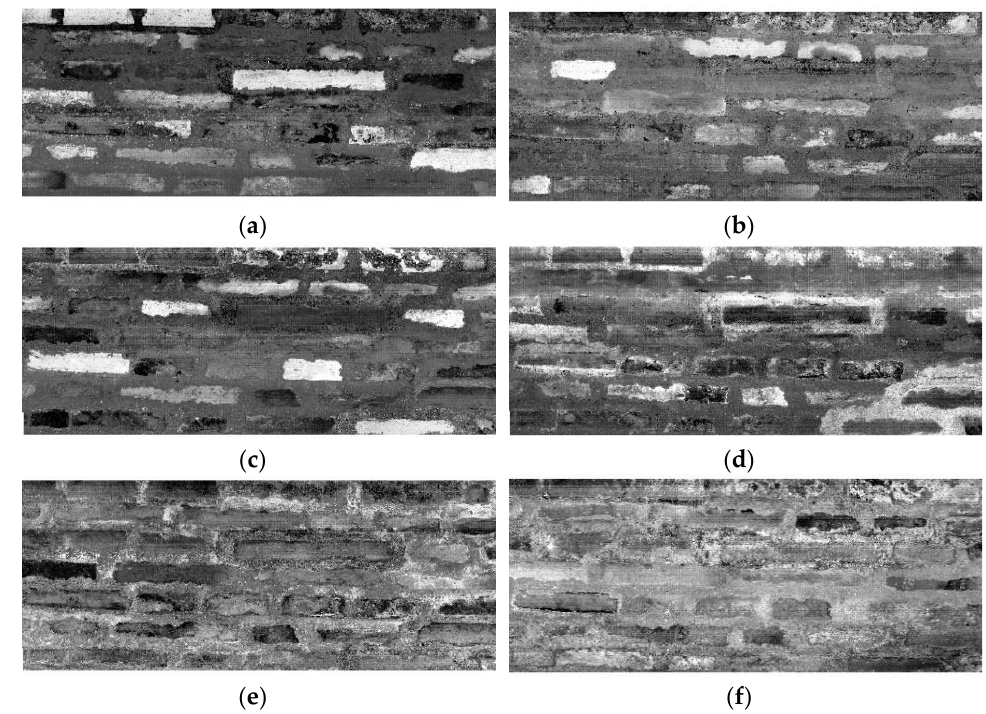
Figure 8. LSU classification results for ( a ) brick #1, ( b ) brick #2, ( c ) brick #3, ( d ) mortar #1, ( e ) mortar #2, and ( f ) mortar #3.